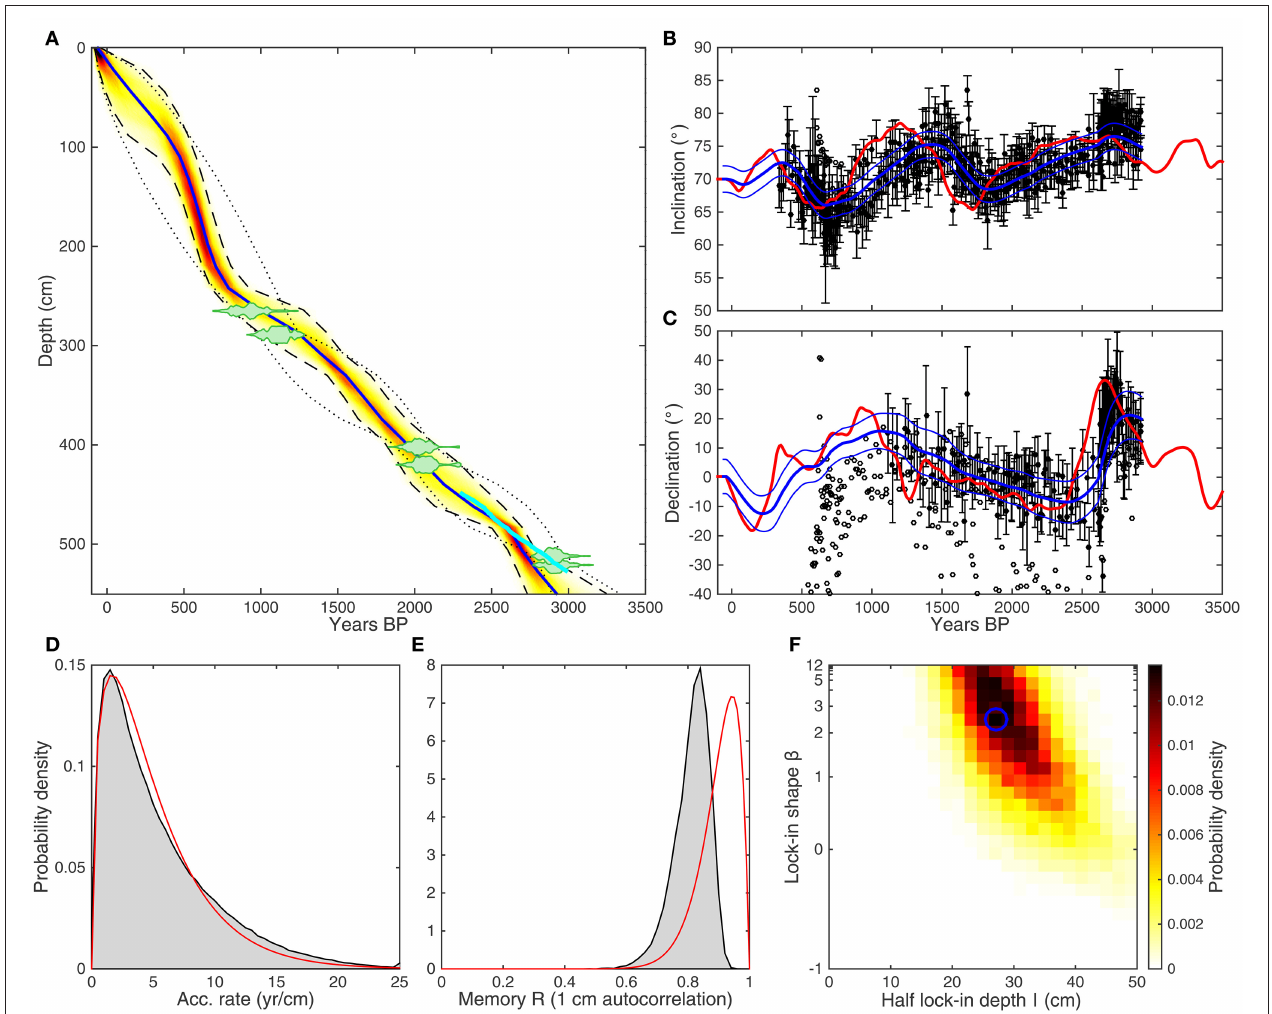
FIGURE 3 | (A) The age-depth posterior distribution for Gyltigesjön based on paleomagnetic data (yellow/red shading) with the 95% confidence envelope (dashed black) compared to the wiggle-match chronology (cyan solid) and the 95% confidence envelope of the radiocarbon-based chronology (dotted black). Calibrated probability density curves of available macrofossil radiocarbon dates are shown for reference as green shaded areas. The blue line represents the preferred age-depth model based on the weighted mean age for each depth. (B) Inclination and (C) declination data (filled black circles) with one sigma error compared to the ARCH3k_cst.1 geomagnetic field model prediction (solid red) filtered with the preferred lock-in function (solid blue) with 1 σ uncertainty envelope. Rejected data are shown as open black symbols. In the lower panels: The prior (red) and posterior (gray) distributions of (D) accumulation rate and (E) memory. (F) The posterior distribution of the half lock-in depth ( l ) and lock-in shape( β ), where the blue circle marks the “preferred” parameters, determined by the grid cell with highest